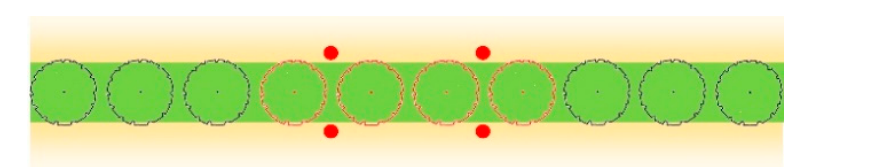
Table 1. Summary of sampling techniques used in the study. For further information on sampling methodology, see Table S2. Purpose Sampling Technique